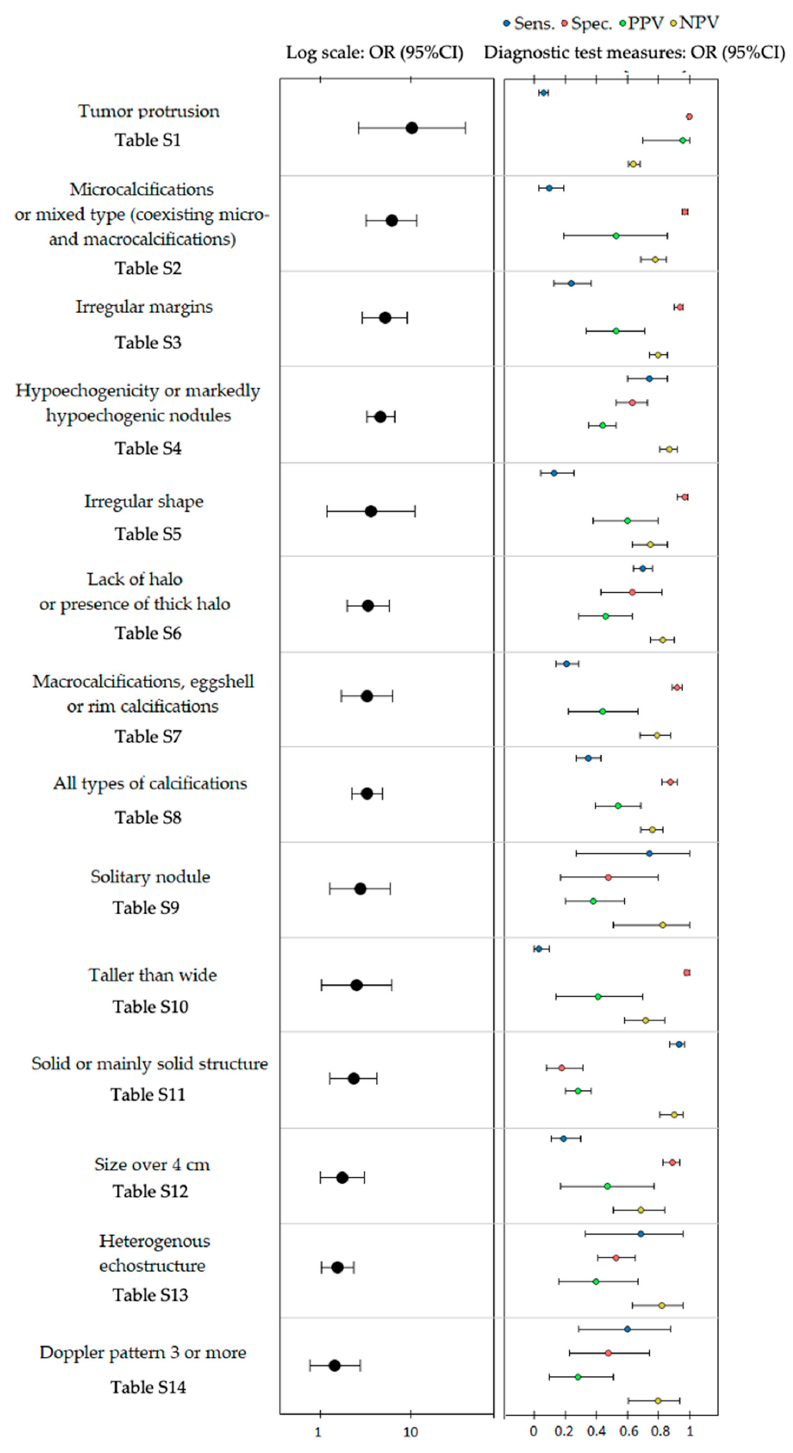
Figure 2. The graphic presentation of overall specificity, sensitivity, negative prognostic value (NPV), and positive predictive value (PPV) for sonographic features differentiating follicular thyroid cancer from follicular adenoma utility and their overall odds ratios (OR) with their 95% confidence intervals (95% CI).